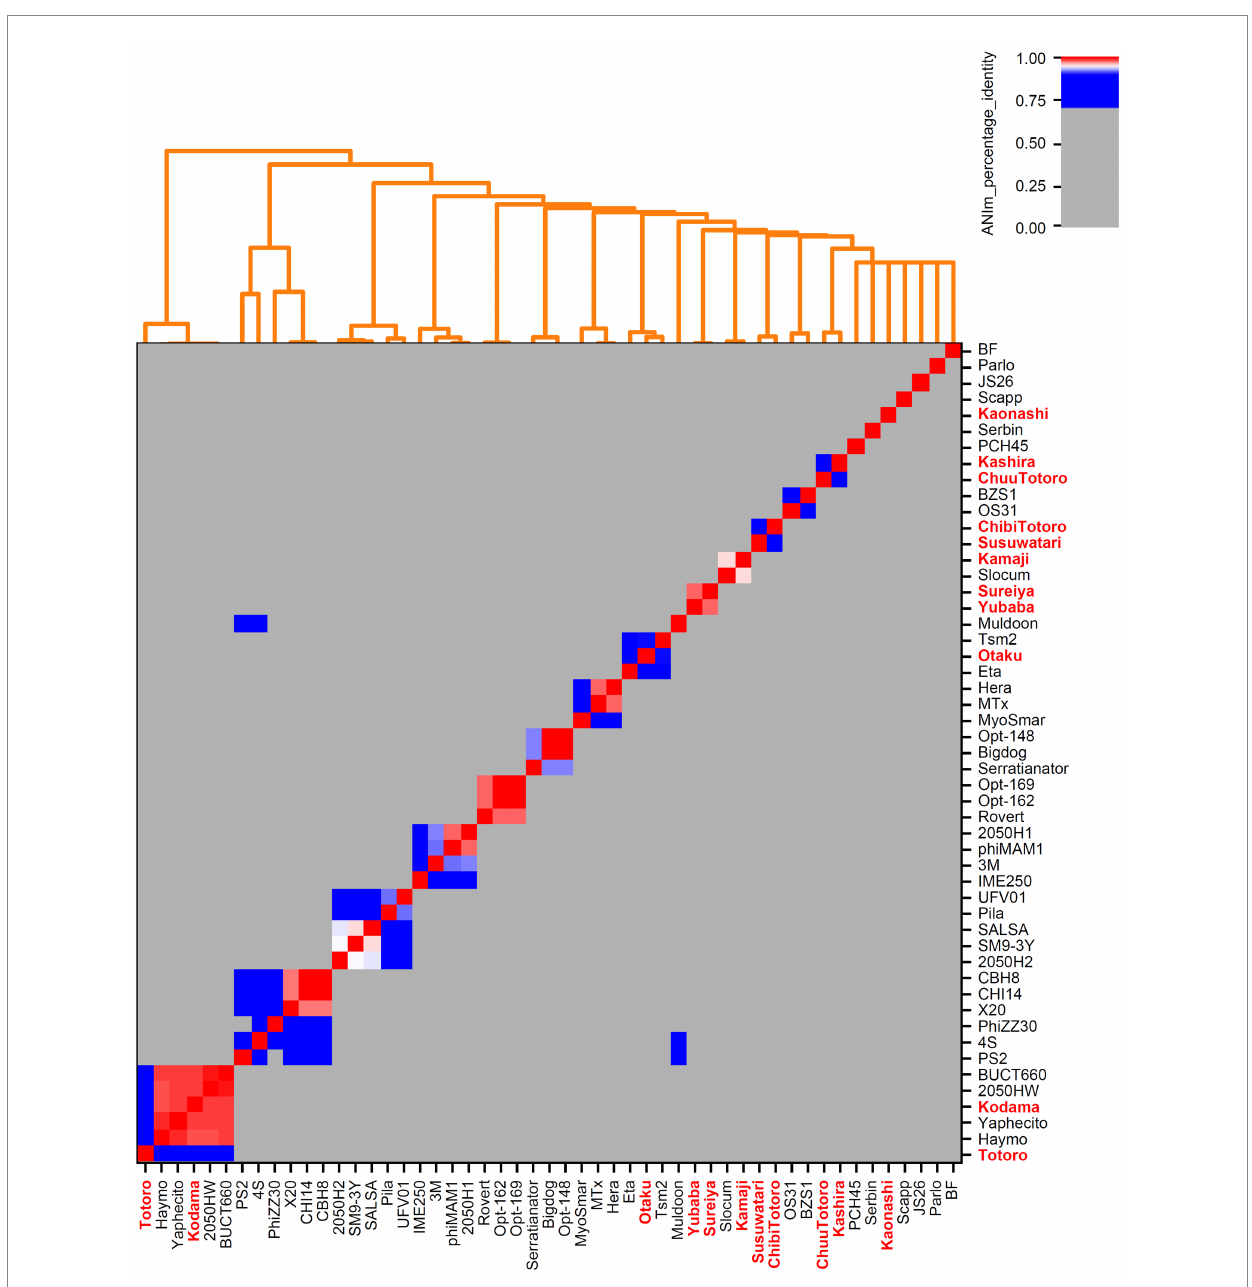
FIGURE 1 Genome-based phylogenetic analysis of Serratia -associated bacteriophages. All genomes from NCBI Virus (Brister et al., 2015) and our own isolates (marked in bold red) were examined. Calculations were done with pyani (Pritchard et al., 2016) using ANIm method with default